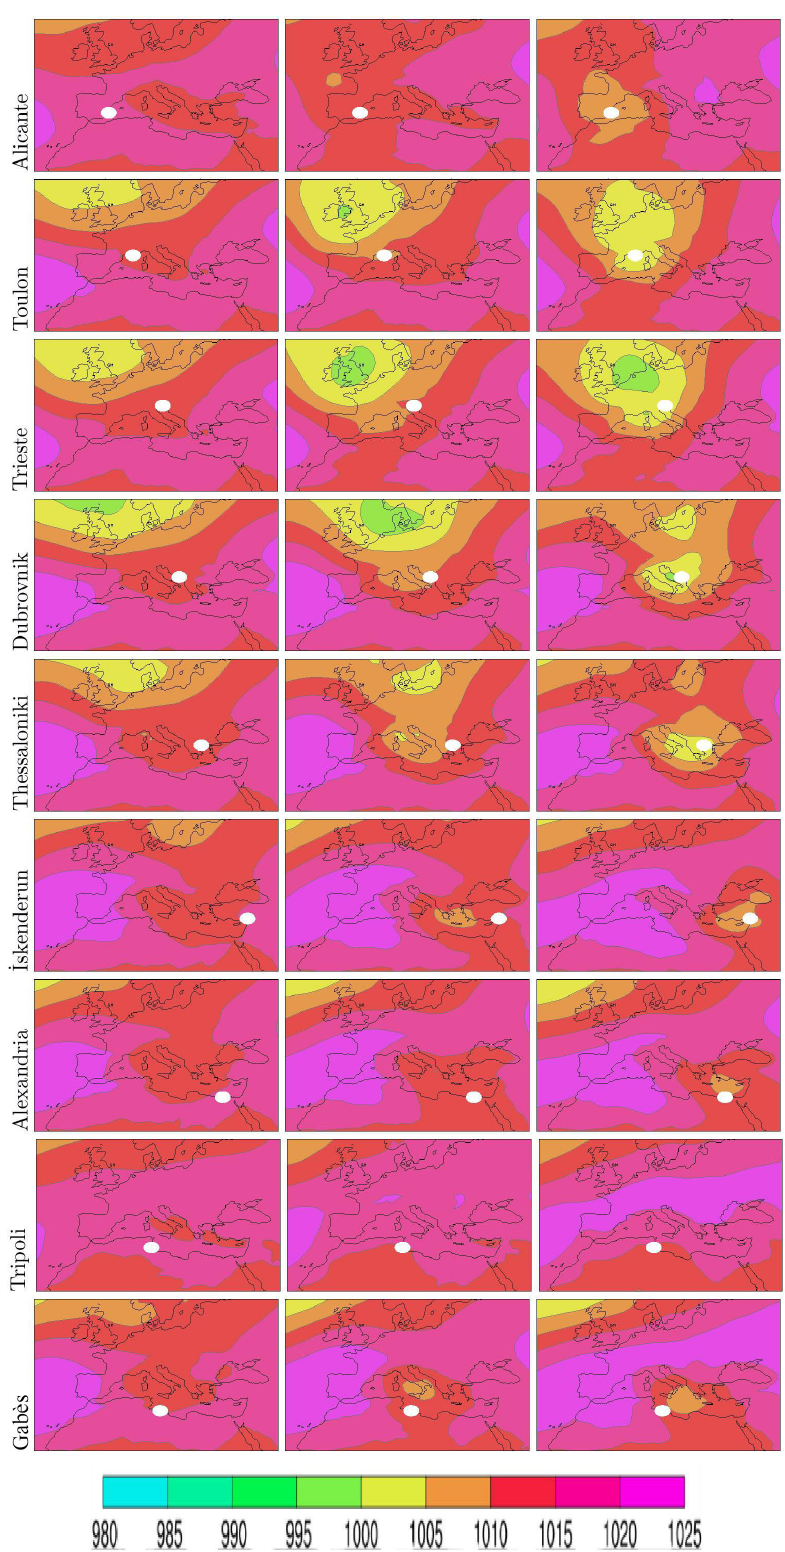
Figure 4. Composites of ERA-Interim MSLP fields (in hPa) associated with the values of large positive sea level anomalies 48h before (left column), 24h before (middle column) and at the peak (right column) of the event in Alicante, Toulon, Trieste, Dubrovnik, Thessaloniki, ˙ Iskenderun, Alexandria, Tripoli and Gabès, denoted with white circles in the